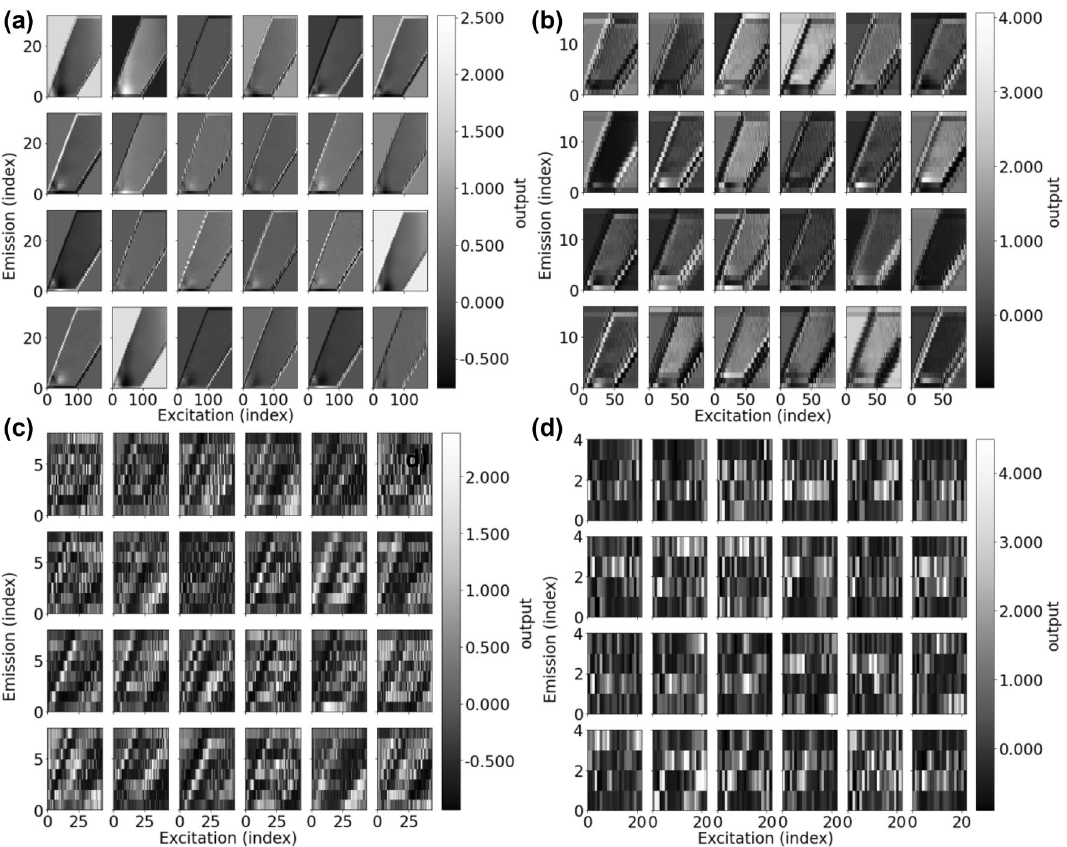
Figure 3. Feature maps of convolutional filters (24) from 4 convolutional layers chosen between max pooling layers. ( a ) First convolutional layer, ( b ) after the first max pooling, ( c ) after the second max pooling, ( d ) after the third max pooling. All max pooling was carried out over a (2, 2)